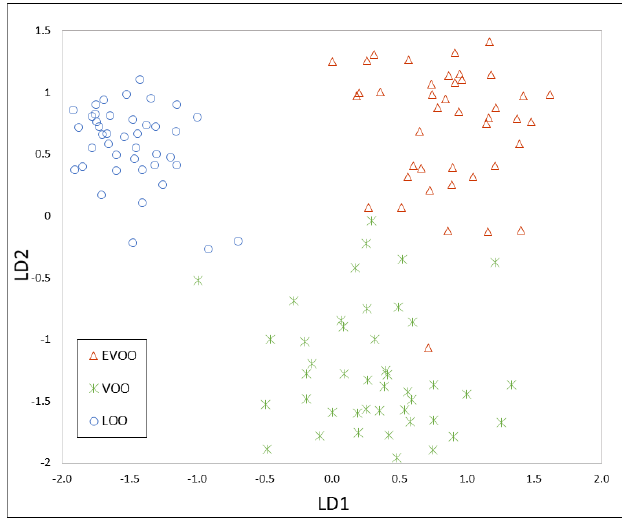
Figure 3. Principal component analysis- linear discriminant analysis ( PCA-LDA) model constructed using the HS-GC-IMS markers.